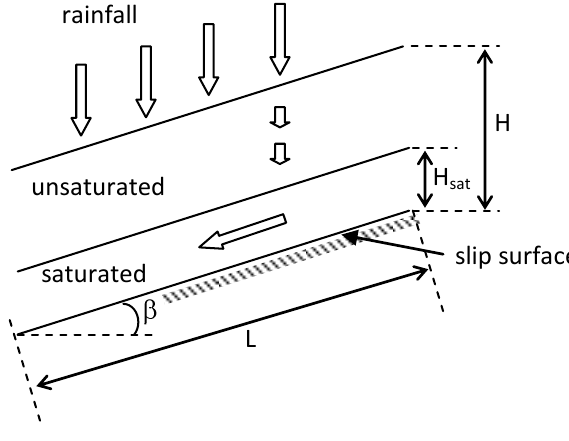
Fig. 5. Plasticity chart for classification of shallow soils involved in Figure 5 soil slips in the test-area. Fig. 6. Sketch of an infinite slope and scheme of the infiltration model. ( β is the inclination of the potentially unstable slope; H is the thickness of the potentially unstable layer; L is the length of the soil